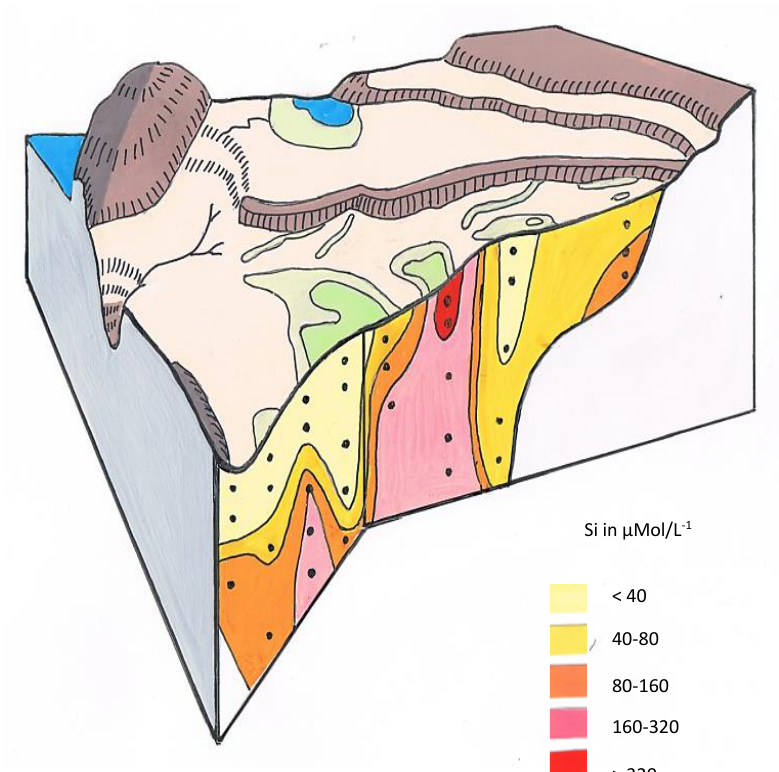
Figure 8. Silicon contents (µmol L -1 ) of pore water in peat profiles on Transects I and